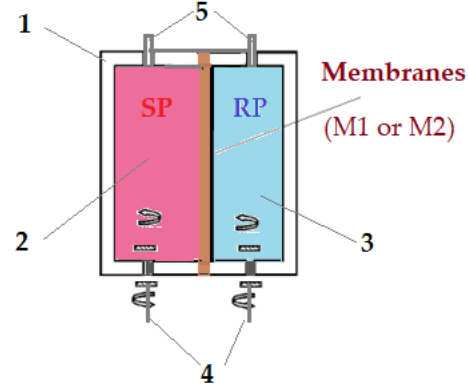
Figure 3. Schematic representation of pertraction installation for the melatonin transport through prepared membranes (M1 and M2): 1-pertraction module; 2-source compartment; 3-receiving com- partment; 4-magnetic stirrer system; 5-pipes; source phase (SP – 2g/L melatonin neutral aqueous solution); receiving phase (RP – pH and salinity-controlled